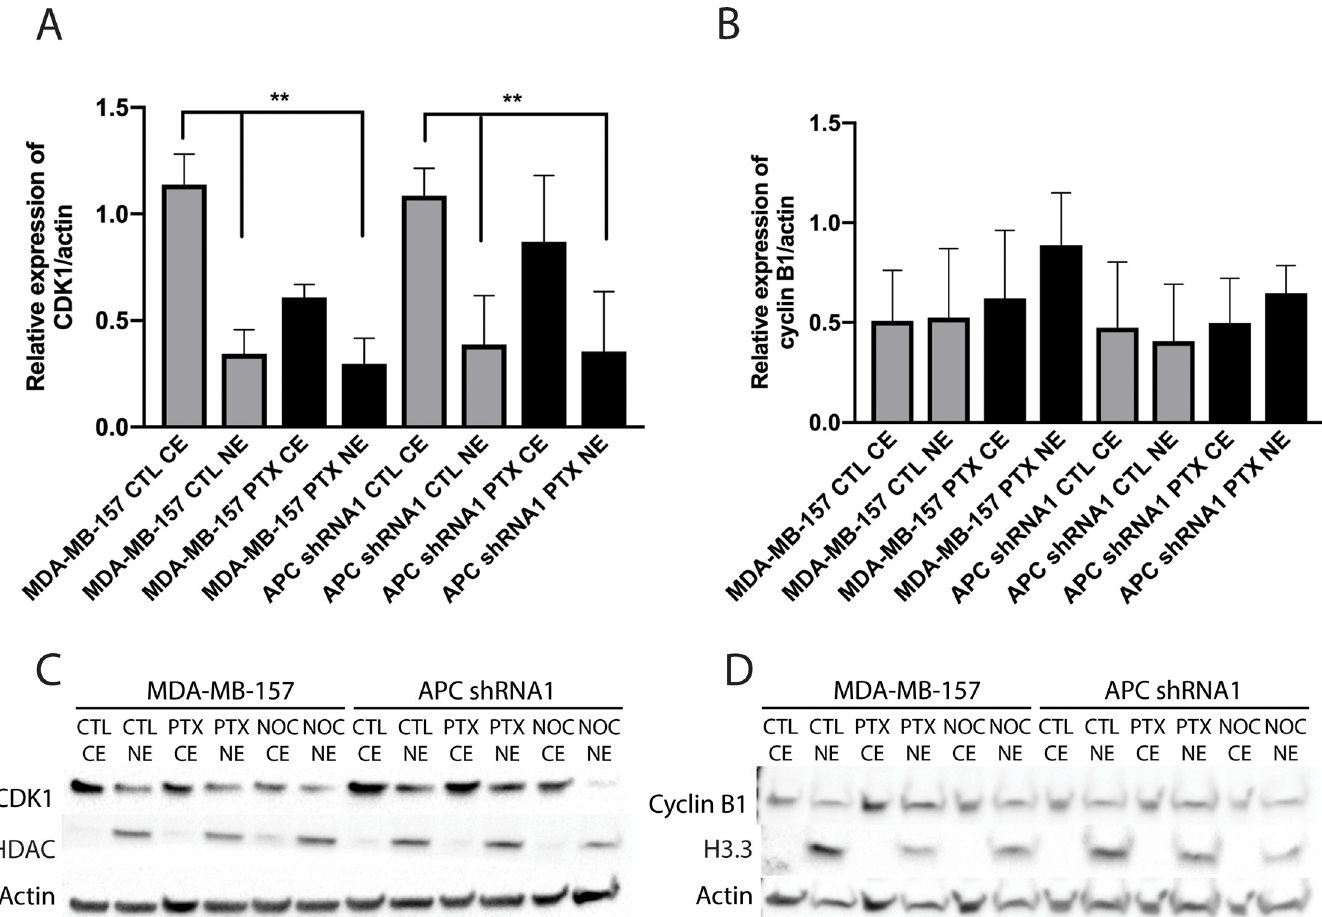
Fig 3. Western blot analysis of cellular fractions. Protein lysates from CTL, PTX, or nocodazole (NOC) treated cells were fractionated and then probed with CDK1 (A and C) or cyclin B1 (B and D). HDAC and H3.3 were used as loading controls for the nuclear extract (NE) specifically, while actin was used as a widespread loading control. (A-B) Bar graph representation of protein quantification (n = 3). (C-D) Representative western blots are shown. Analysis indicated that CDK1 is preferentially located in the cytoplasm in the untreated parental and APC shRNA1 cells. Cyclin B1 shows no preferential localization. �� p < 0.01 as compared to corresponding cytoplasmic extract (CE). Westerns were run and membranes cut after transfer. For CDK1, the top portion was probed for HDAC (61kD), and the bottom portion was probed for CDK1 (34kD) and actin (42kD). For cyclin B1, the top portion was probed for cyclin B1 (55kD) and actin (42kD), and the bottom was probed for Histone H3.3